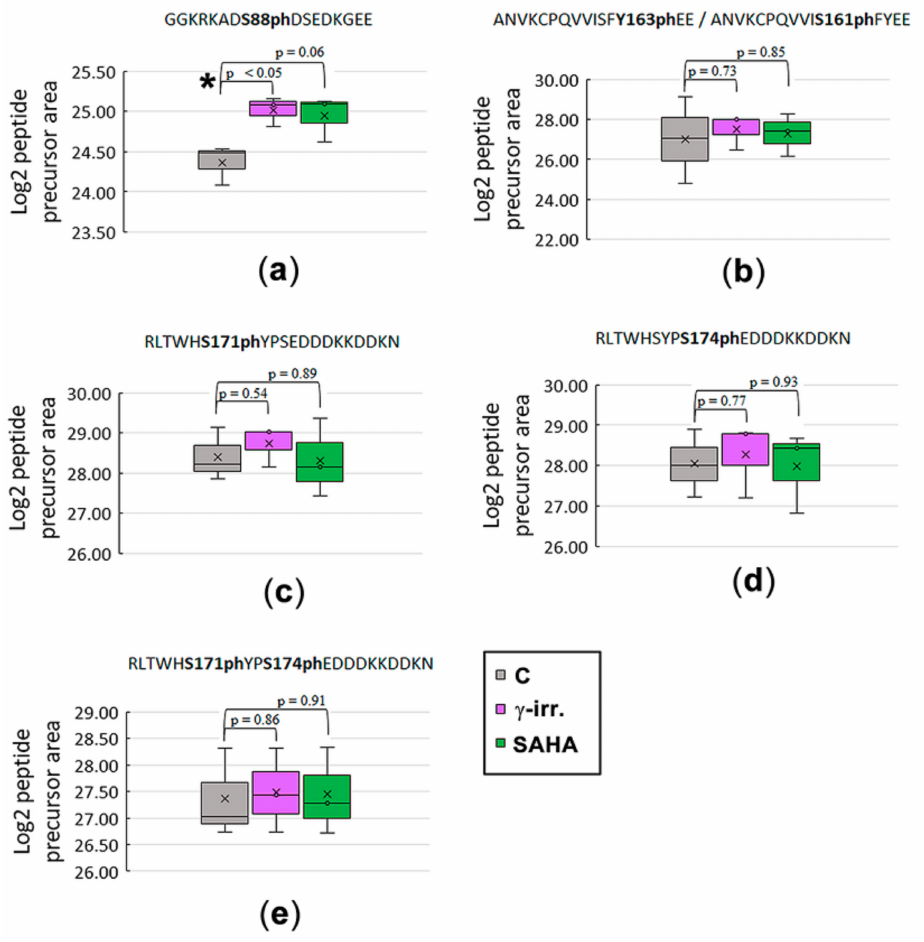
Figure 4. The proportion of signature marks on HP1 β protein in non-treated, γ -irradiated, and SAHA treated human cervix adenocarcinoma (HeLa) cells. Box-plots of the relative abundance of particular phosphopeptides showing extremes, interquartile ranges, means and medians ( N = 3). Precursor peak of phosphopeptides was quantified in Skyline SW. Data were normalized to the sum of selected non-modified peptides. Following post-translational modifications were analyzed: ( a ) HP1 β -S88ph; between samples in normalized peptide abundances ≥ 1.5-fold were considered as significant, and the significance of di ff erences was assessed using Student’s t-tests, setting the significance threshold at P < 0.05 (shown by the asterisk). Cells were harvested 2 h after the treatment; 5Gy of γ -rays or 15 µ M